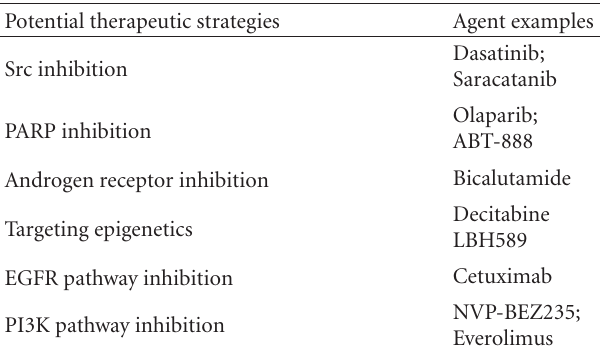
Table 3: Potential Therapeutic Strategies and agent examples for